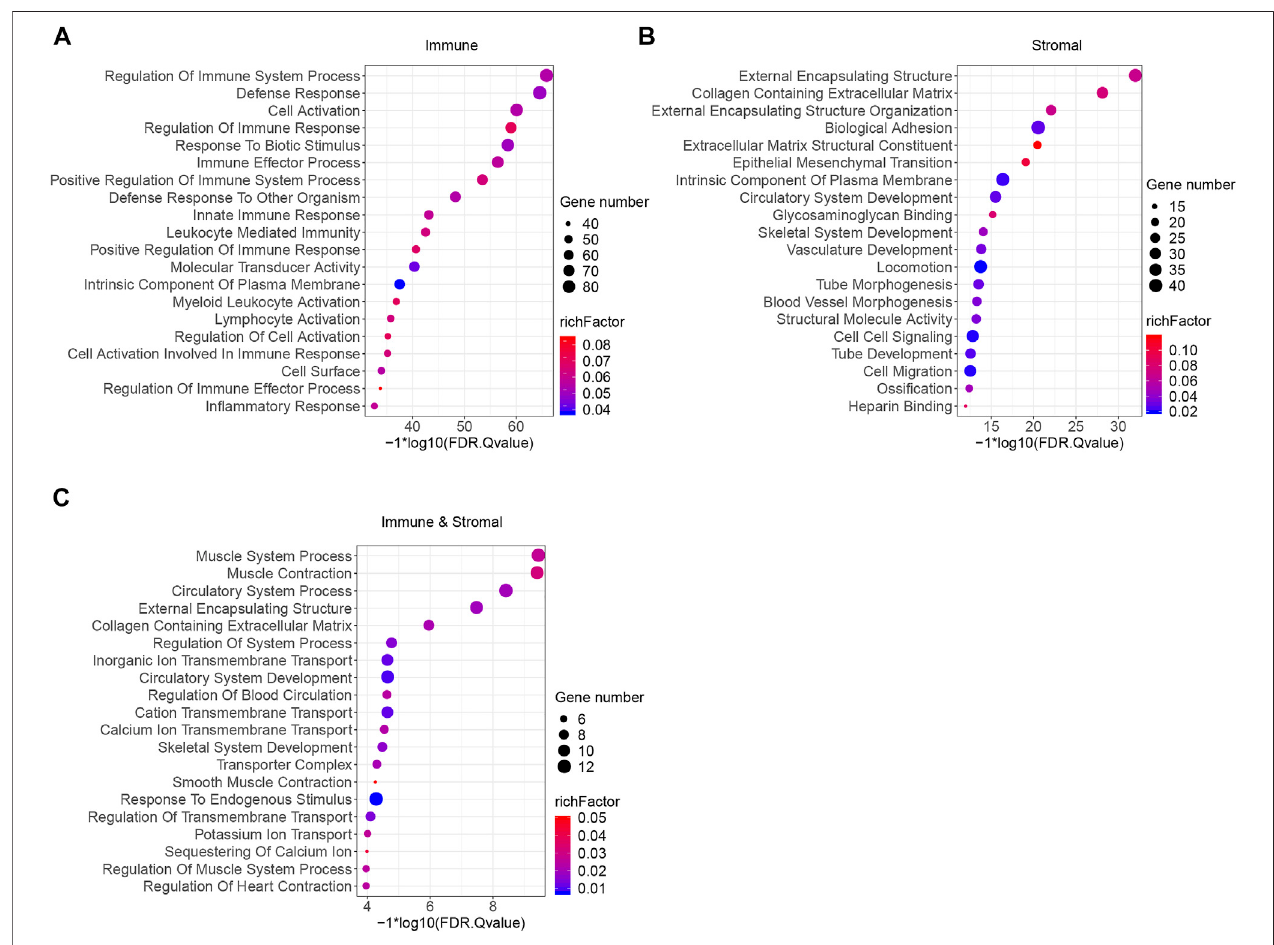
FIGURE 4 | Functional enrichment analysis of immune and stromal scores related DEGs. (A) GSEA analysis results of immune score related DEGs. (B) GSEA analysis results of stromal score related DEGs. (C) GSEA analysis results of immune and stromal score related DEGs. Top 20 terms were exhibited according to the signi fi cance of FDR